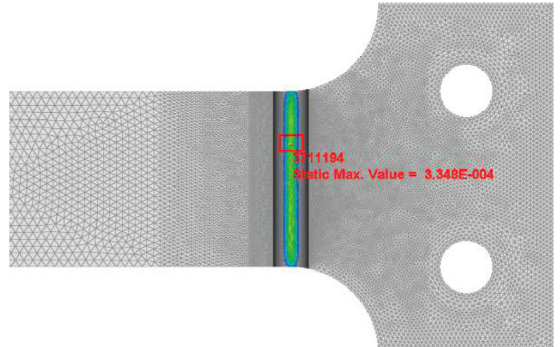
Figure 13: Damage cloud map of the accelerated aluminum alloy notched specimen.